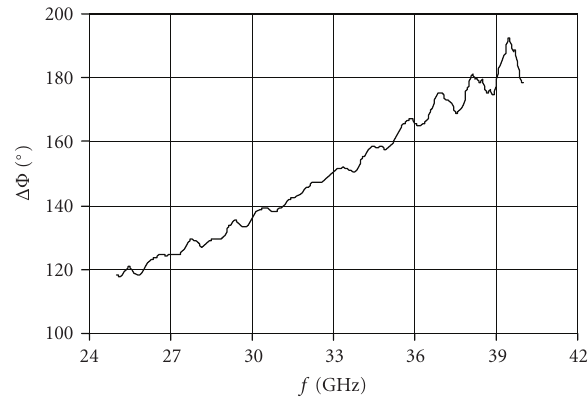
Figure 8: Measured phase shift.